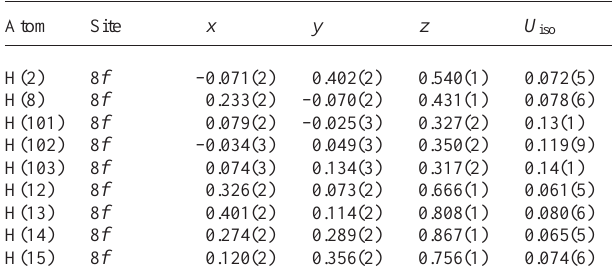
Table 2. Atomic coordinates and displacement parameters (in Å 2 )